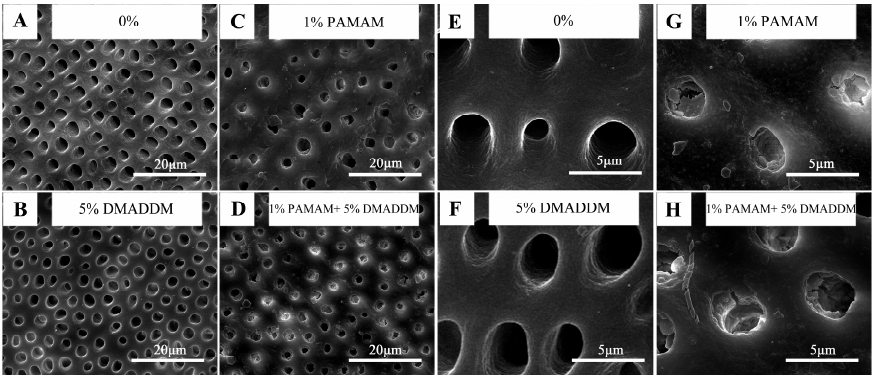
Figure 6. Scanning electron microscope (SEM) micrographs of remineralization effect: in ( A , B ), there were no minerals in dentin tubules. However, in ( C , D ), new minerals could be detected in dentin tubules after 14 days of immersion in artificial saliva solution. ( E – H ) are the higher magnification of ( A – D ), respectively, to show the tubules more obviously.